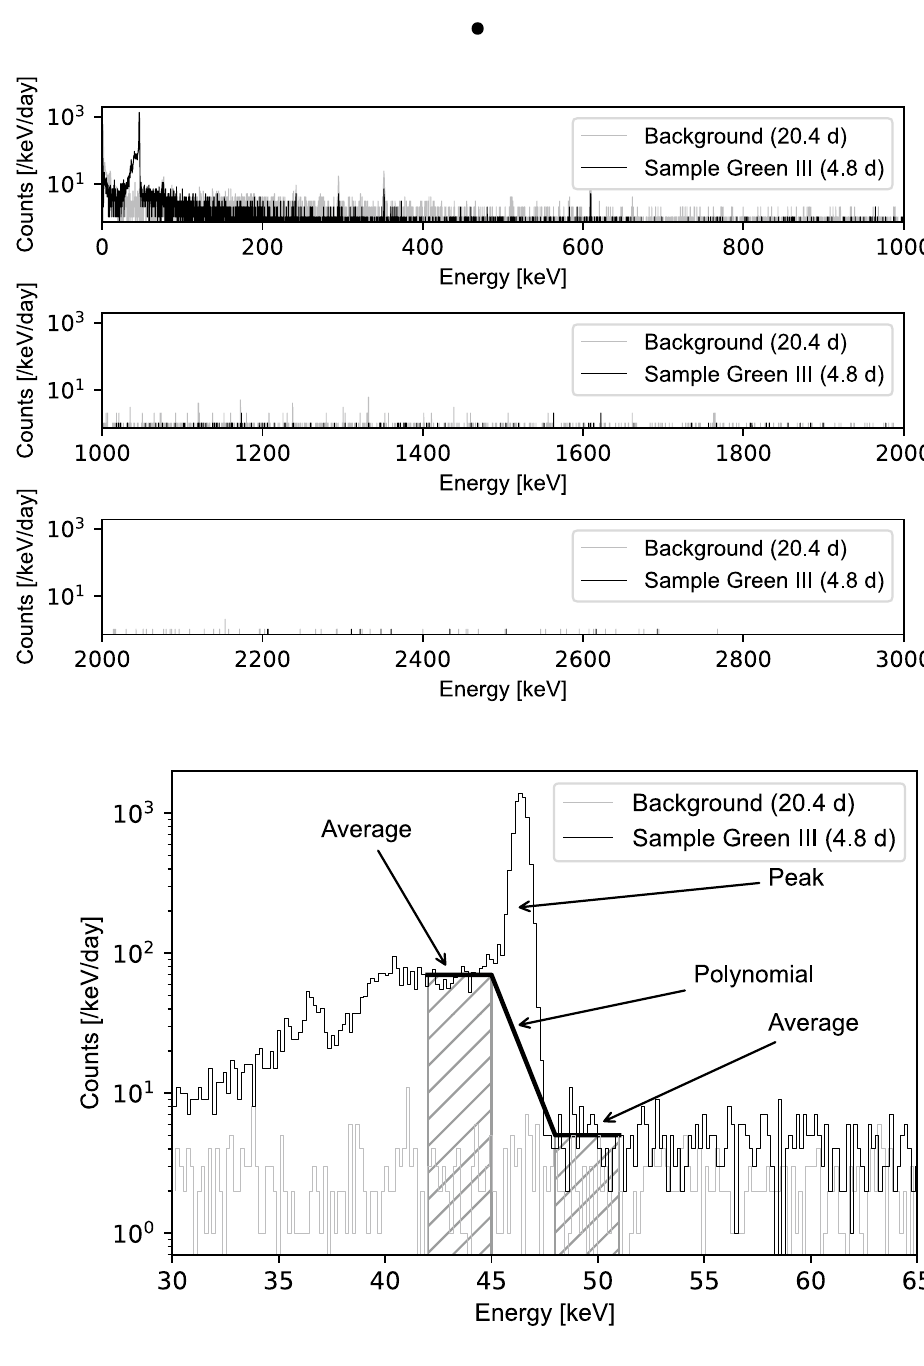
Fig. 7 Sample Green III—full spectrum for this sample in black, and the background spectrum in grey